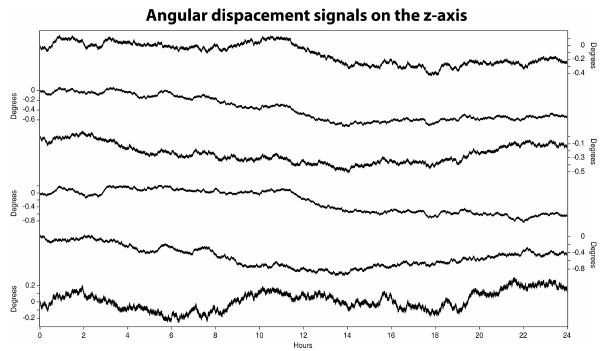
Figure 6. Angular displacement determined from the signals of Fig.